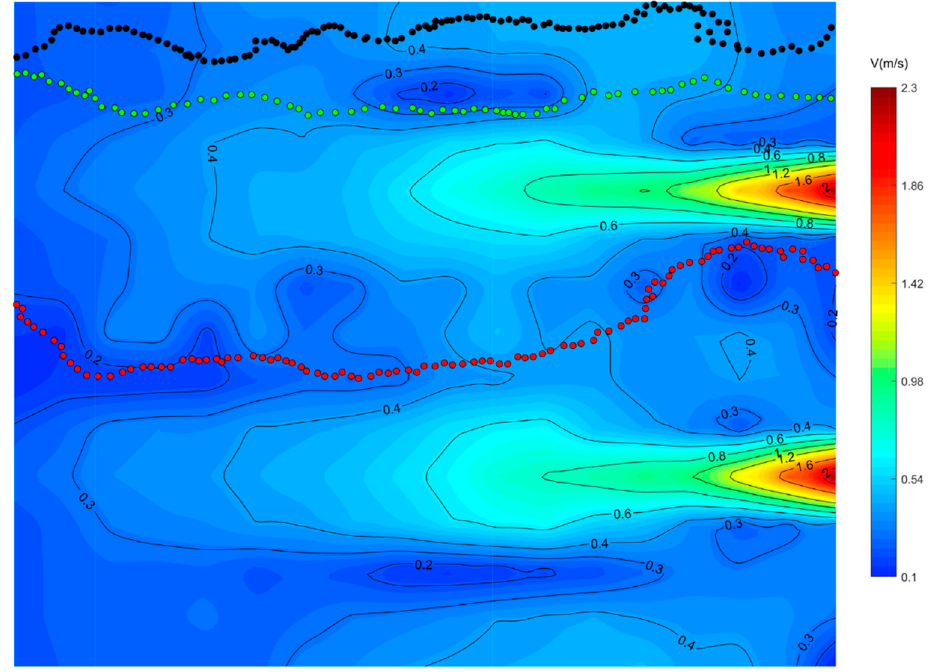
Figure 7. Superposition of representative swimming trajectory and flow field in the focused observation cell for the lateral symmetric bimodal outflow condition.